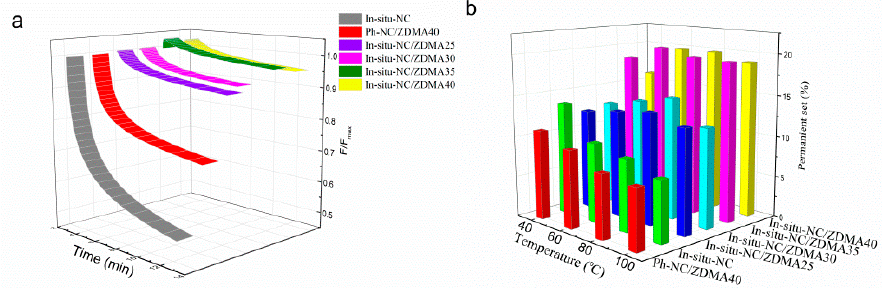
Figure 13. ( a ) Stress relaxation curves and ( b ) residual deformation after recovery for 10 min under respective temperatures.